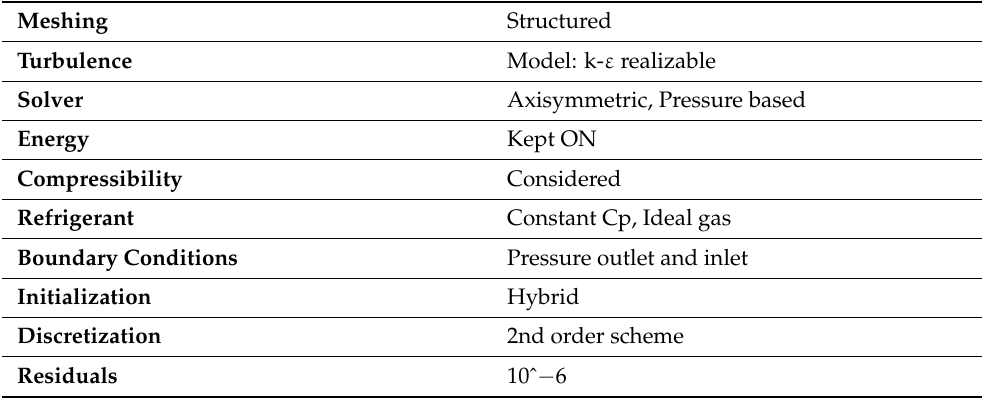
Table 1. Summary of CFD model application settings in ANSYS-FLUENT.